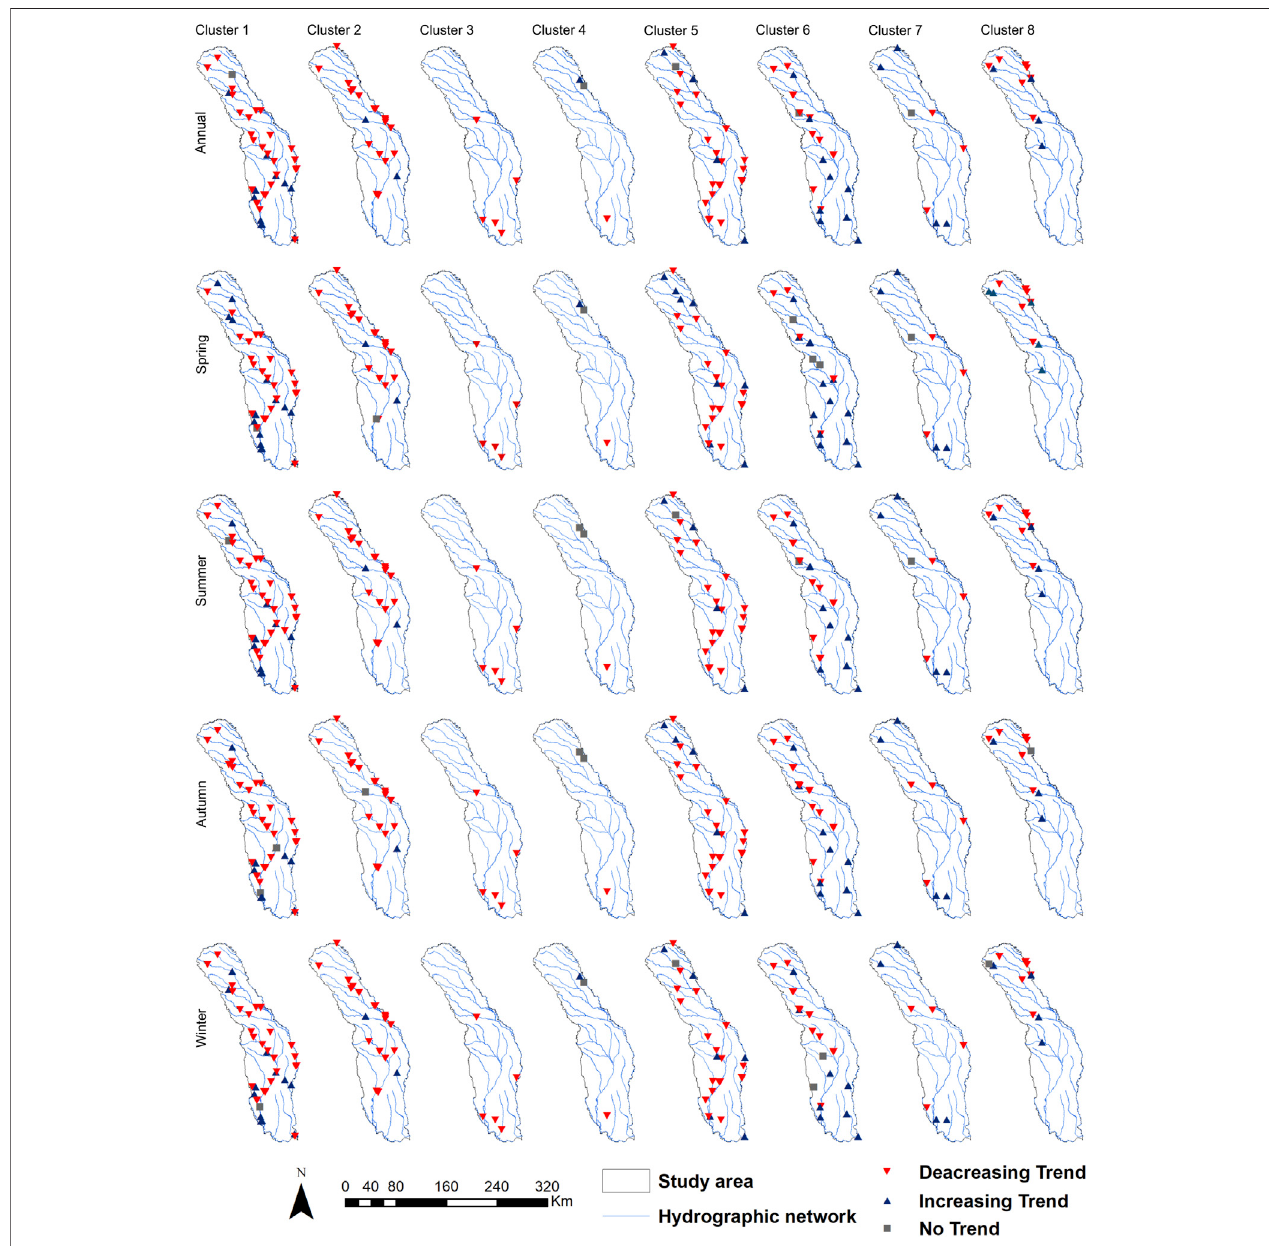
FIGURE 7 | Spatial distributions of the seasonal and annual trends at the cluster level using ITA